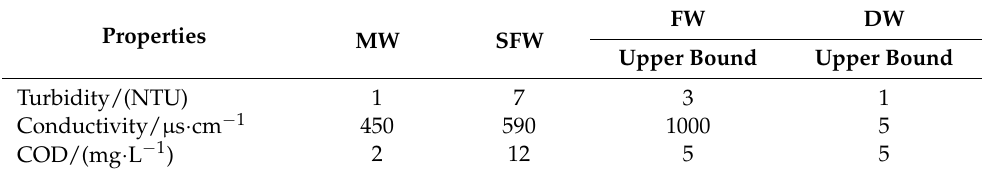
Table 3. Properties of the water resource, freshwater, and desalted